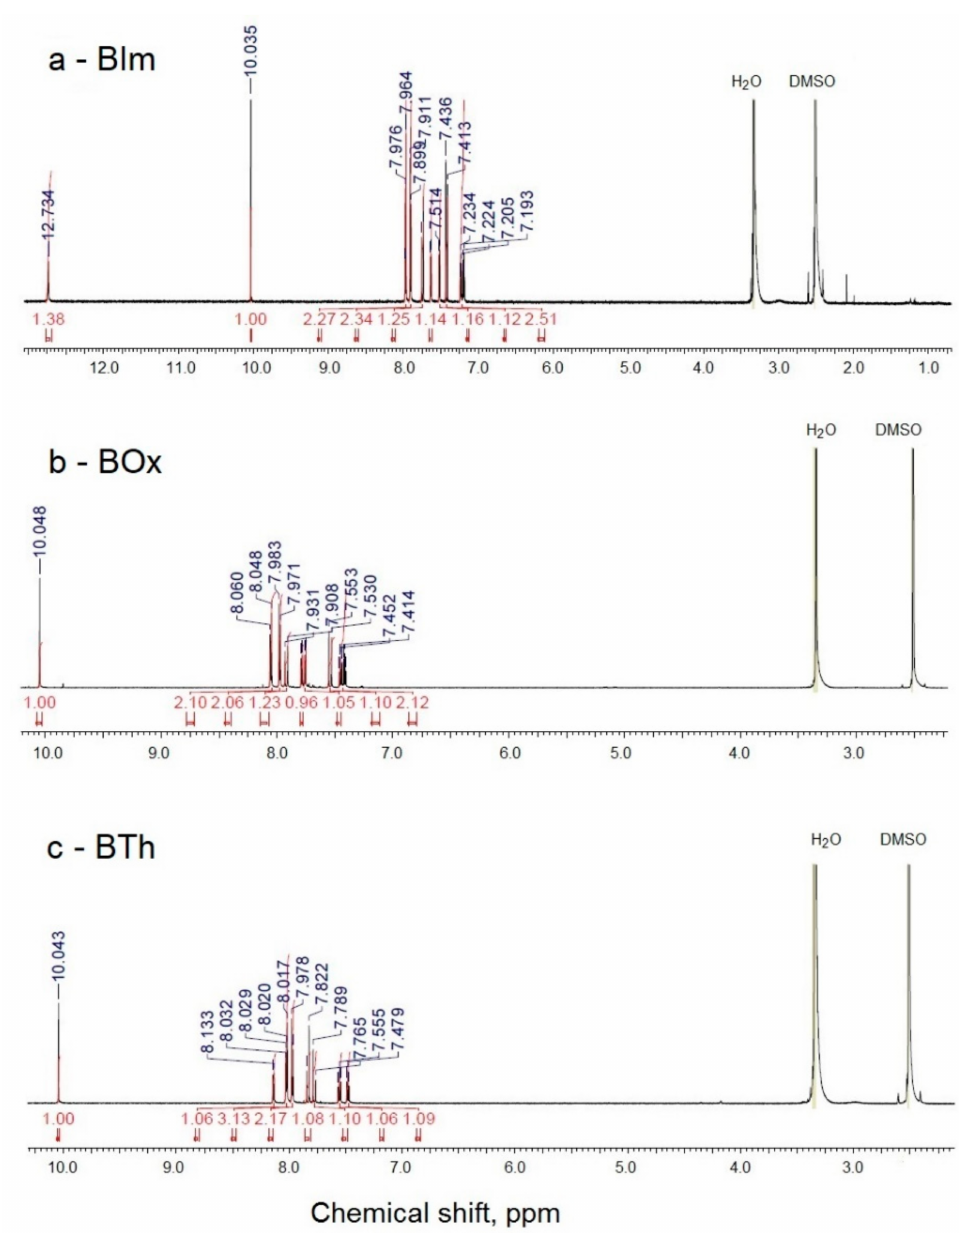
Figure 1. 1 H NMR spectra of dyes BIm ( a ), BOx ( b ), and BTh ( c